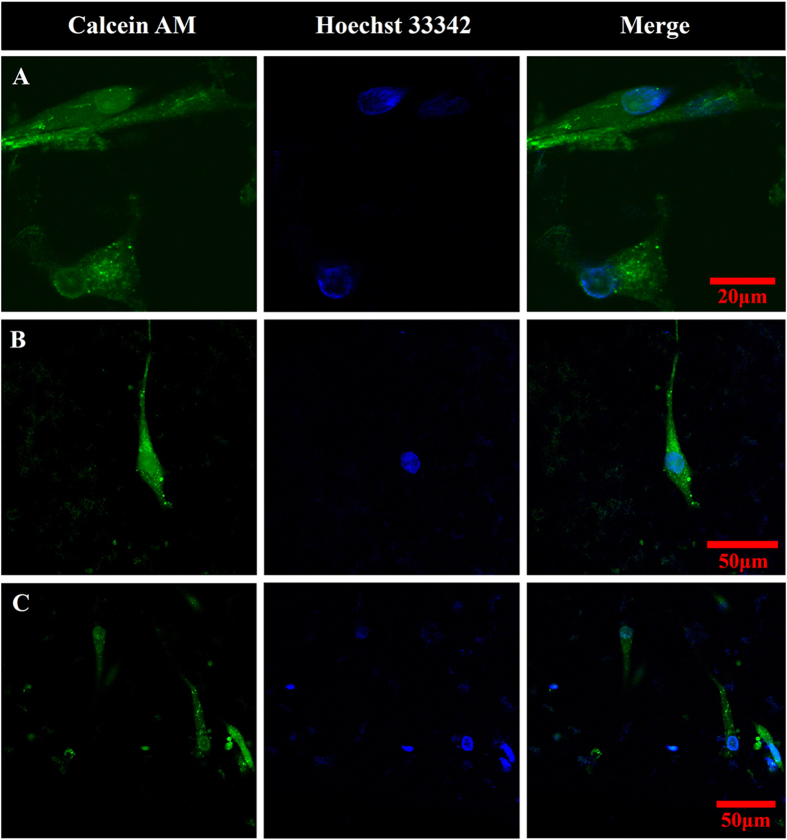
Representative confocal fluorescence microscopy of ADSCs stained with Calcein-AM (λex = 488 nm, λem = 505 nm) and Hoechst 33342 (two-photon λex = 800 nm, λem = 465 nm) grown on glass coverslips (A) and MWCNT crosslinked substrates (B and C) for 5 days at 37 °C.